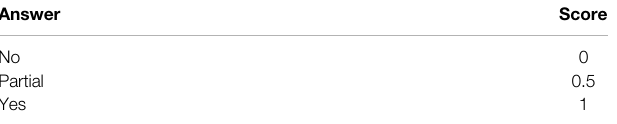
TABLE 10 | Score of the quality assessment questions.